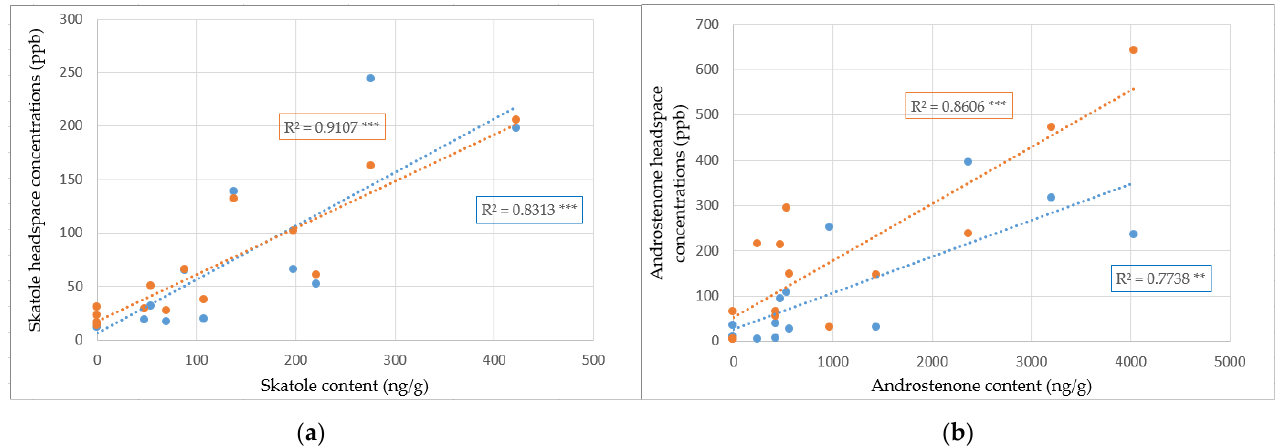
Figure 4. Correlation plots between headspace concentrations (ppb) and content concentrations (ng/g) of skatole ( a ) and androstenone ( b ) respectively at 150 °C (in blue, n = 7) and 180 °C (in orange, n = 7). For the content, values below the linearity range were set at 0 arbitrarily. Pearson correlation coefficients as well as their significance levels are represented on the graph. **, and *** indicate p -values < 0.01, and <0.001, respectively.